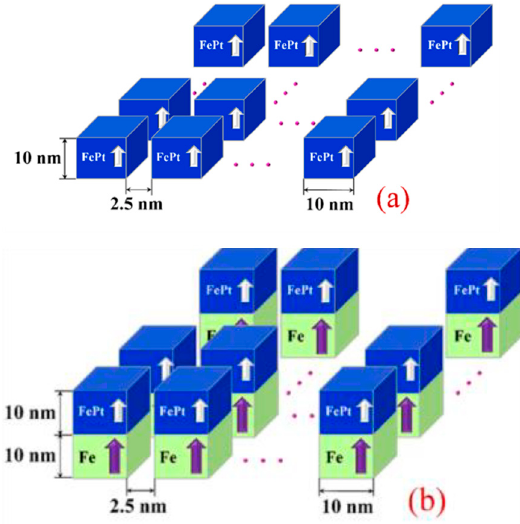
Figure 1. ( a ) Single layer BPM and ( b ) bilayer ECC - BPM.